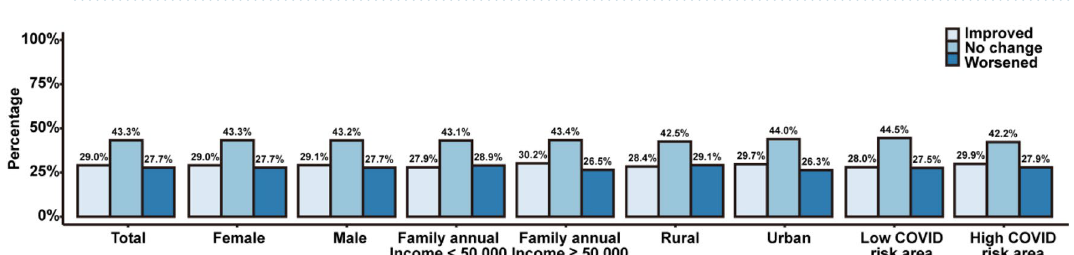
Figure 3. The change of severity of stress symptoms by sex, family income, urban/rural areas, and COVID- 19 risk areas between 2019 and 2020. Notes: Statistically significant difference was found in individuals from annual income ≥ 50,000 RMB families ( p -value = 0.008).